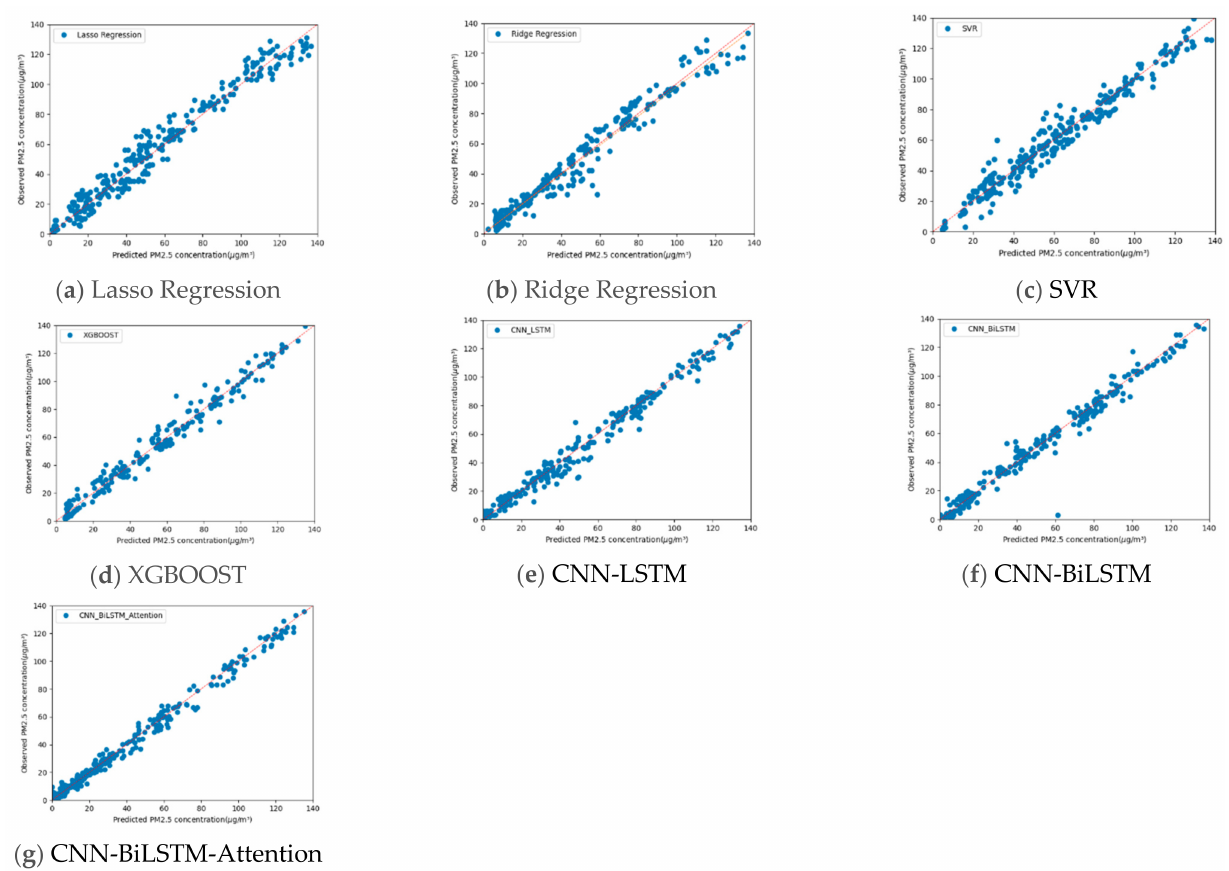
Figure 9. Comparisons of the observed and predicted values of PM2.5 concentration values.